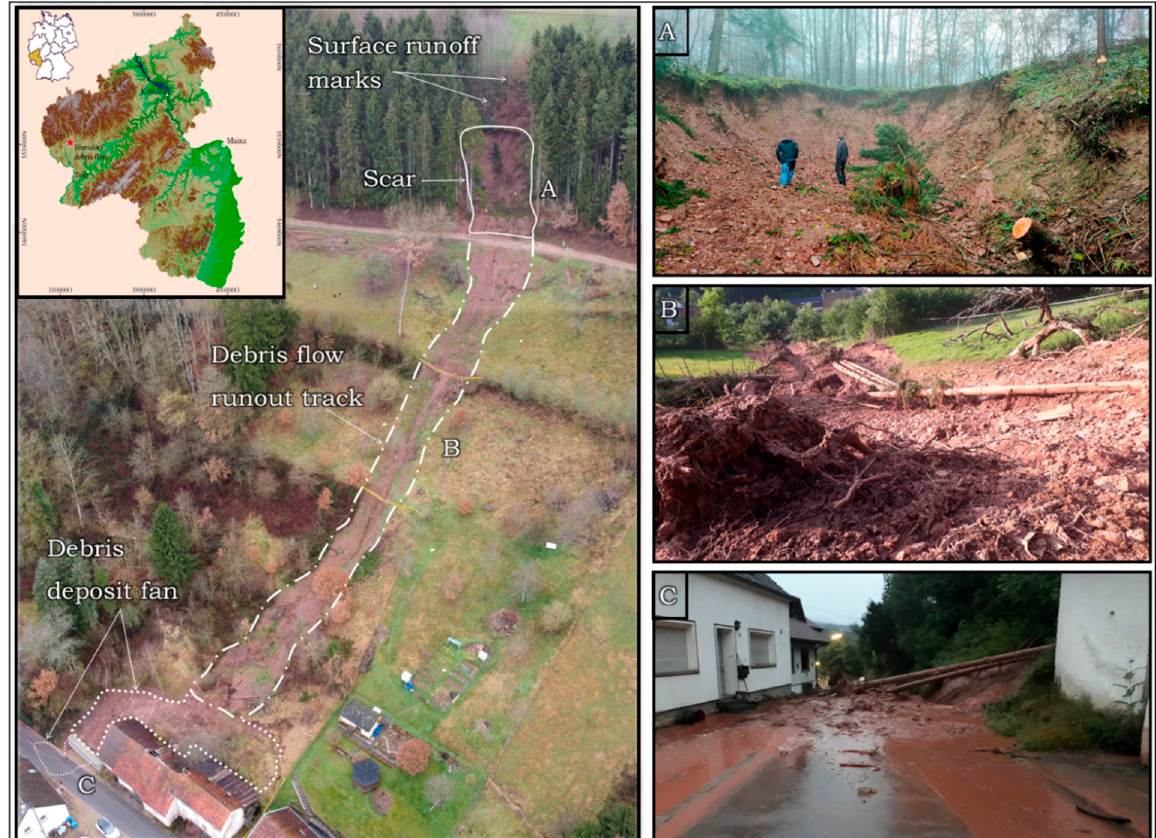
Figure 1. Aerial view of the hillslope debris flow of Biersdorf that occurred on 14 July 2021 with the associated location in Rheinland-Pfalz (Photo taken on 2 February 2022). ( A ) View into the scar. ( B ) Downhill view of the runout track. ( C ) Debris deposits on the municipal road (Photos taken on 15 July 2021).